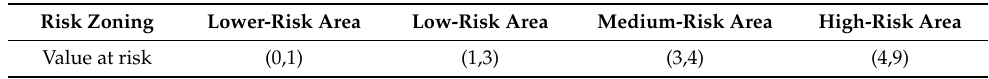
Table 10. Risk zoning standards of the study